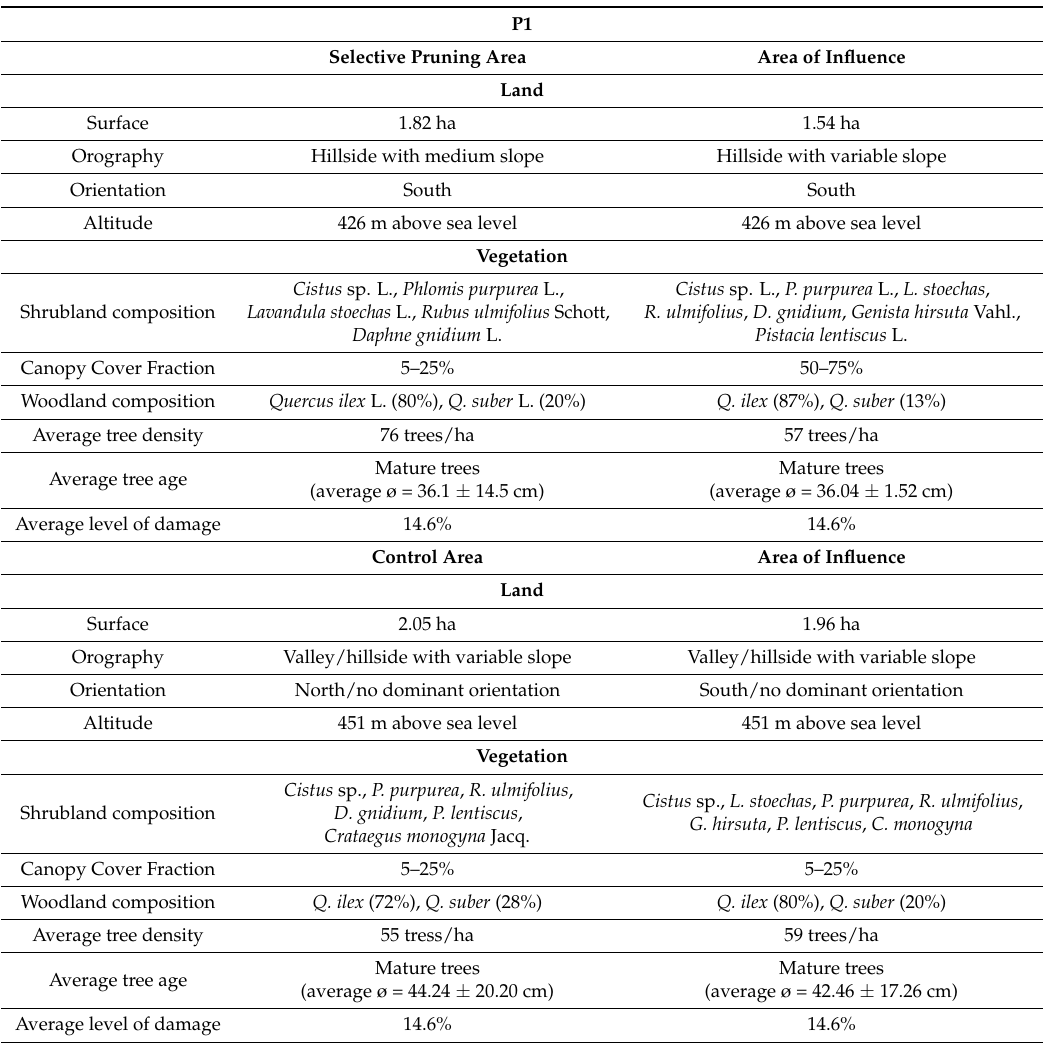
Table A1. Environmental features of each of the selected areas in P1 with specific regard to land (surface, orography, orientation, and altitude) and vegetation (vegetal composition and coverage, tree density, woodland age, and average level of damage by C. florentinus )